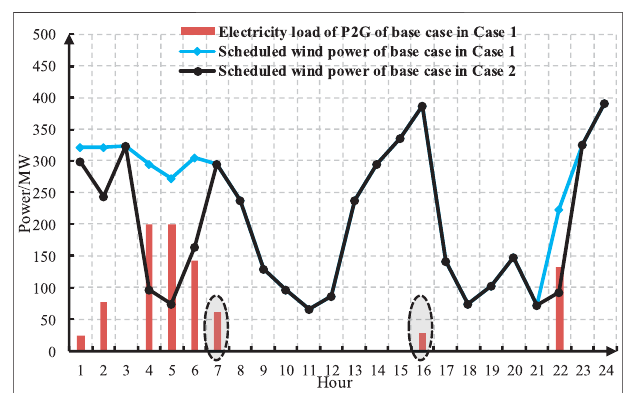
FIGURE4| Comparison ofscheduled wind powerand electricityloadof P2G in Case 1 and 2 in base case.